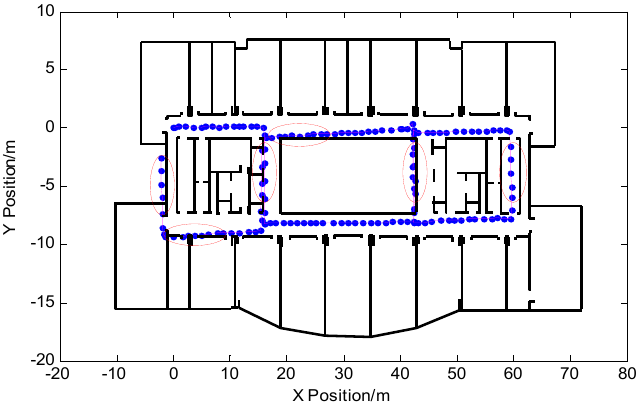
Figure 12. Pedestrian trajectory output by particle filter based on pedestrian dead reckoning.